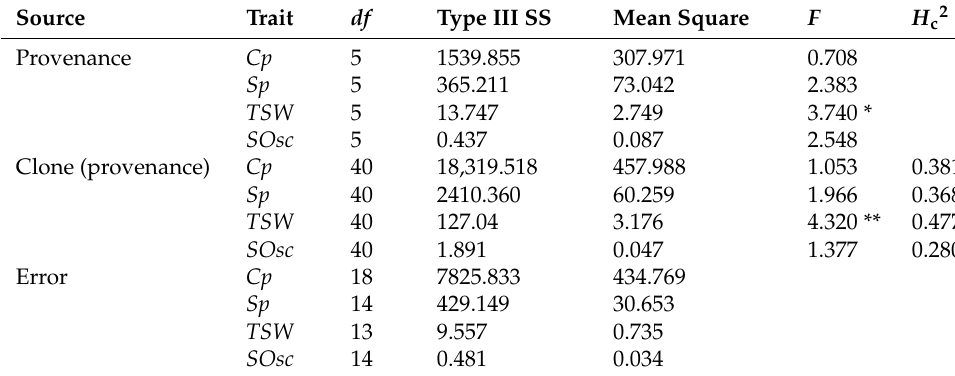
Table 5. GLM-based ANOVA for Cp and Sp